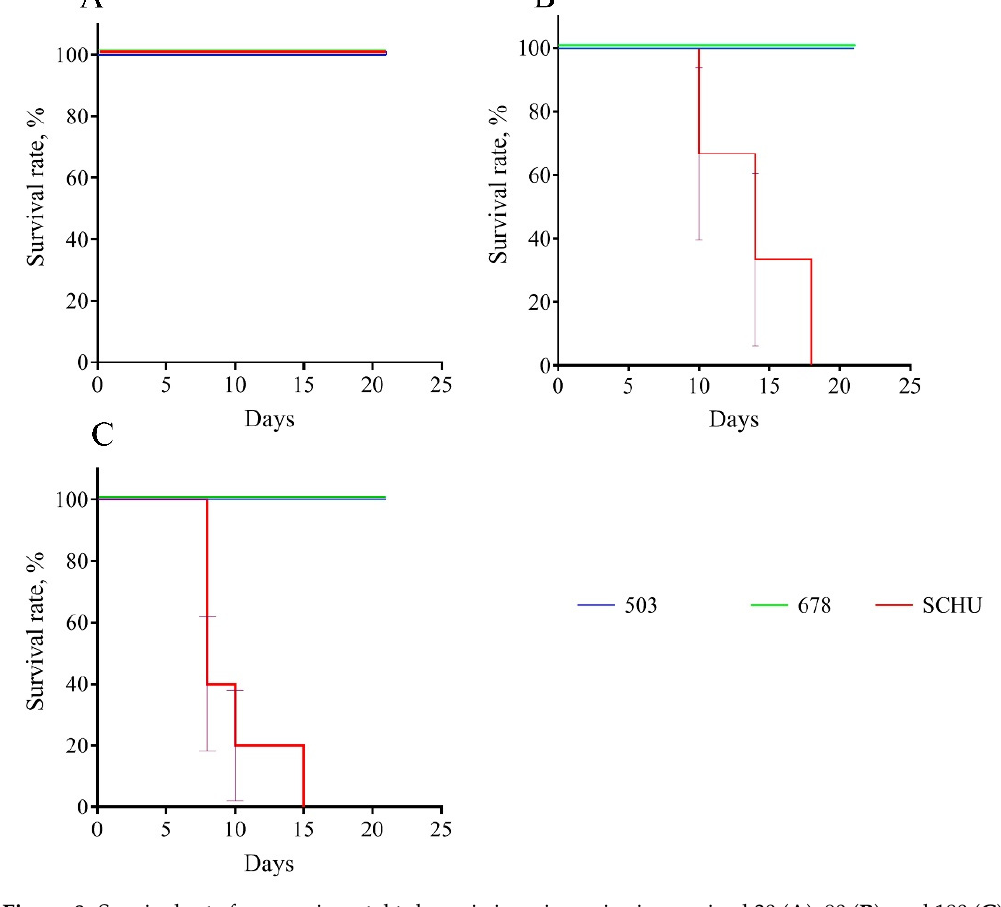
Figure 8. Survival rate for experimental tularemia in guinea pigs immunized 30 ( A ), 90 ( B ), and 180 ( C ) days before infection with virulent strains of F. tularensis : subsp. holarctica 503, subsp. mediasiatica 678, and subsp. tularensis SCHU.